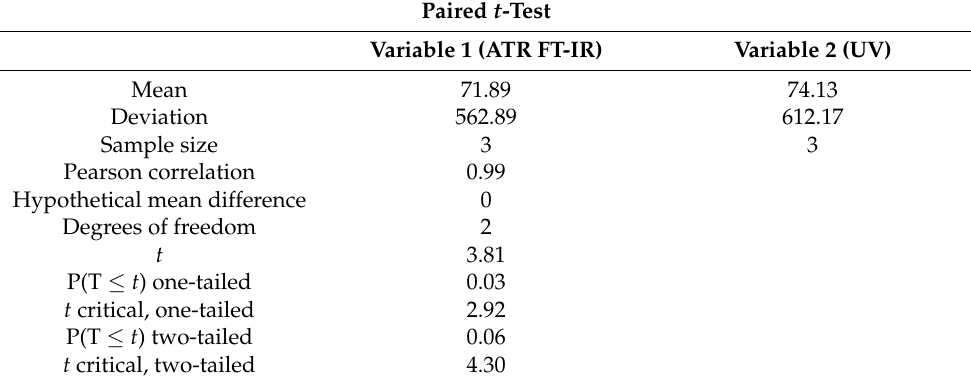
Table 3. Welch’s t